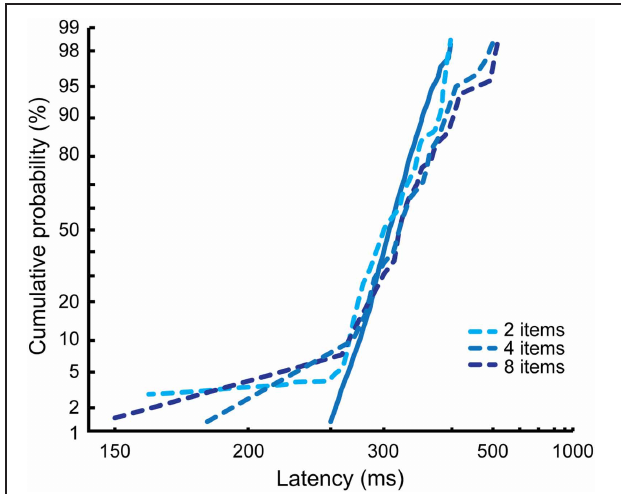
FIGURE 7 | Effects of FEF inactivations on reaction time distributions for ipsilesional targets in the easy feature search condition in Monkey G. The different numbers of items conditions are cumulated for the control condition (solid line), but represented independently for the inactivation conditions (dashed